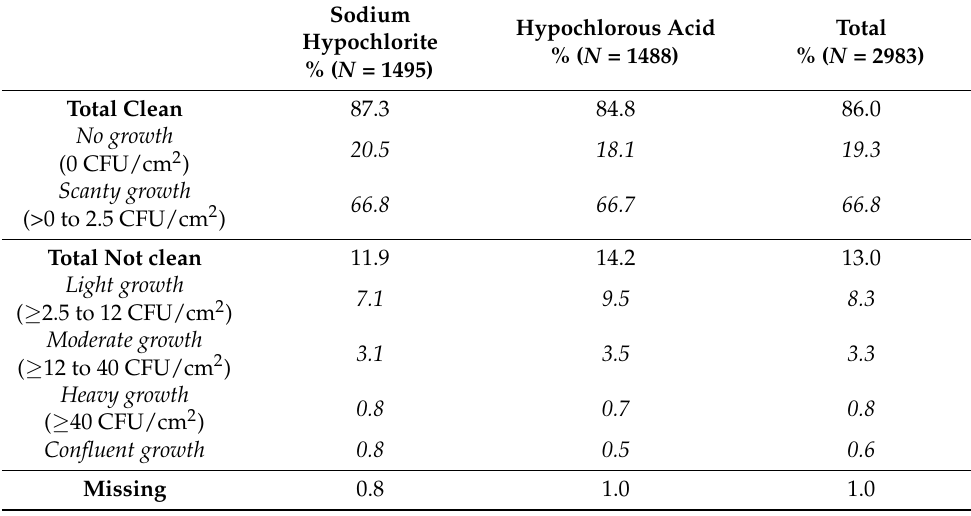
Table 1. Distribution of cleanliness by treatment and by ACC category.